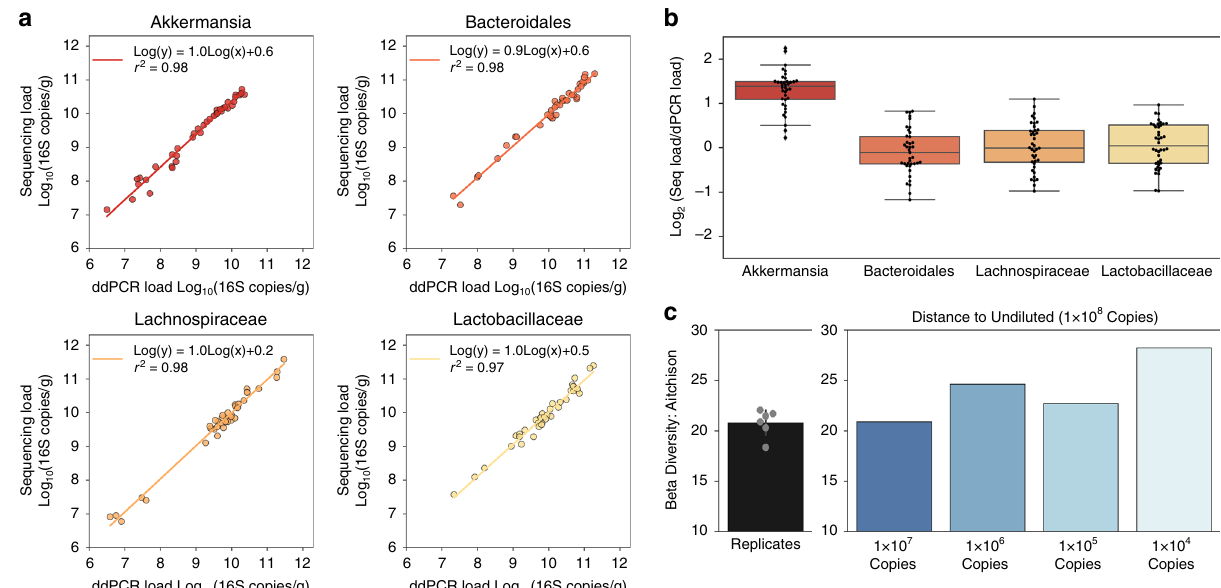
Fig. 3 Digital PCR (dPCR) anchoring of 16S rRNA gene amplicon sequencing provides microbial absolute-abundance measurements. Taxon-speci fi c dPCR demonstrates low biases in abundance measurements calculated by 16S rRNA gene sequencing with dPCR anchoring. a Correlation between the Log 10 abundance of four bacterial taxa as determined by taxon-speci fi c dPCR and 16S rRNA gene sequencing with dPCR anchoring (relative abundance of a speci fi c taxon measured by sequencing × total 16S rRNA gene copies measured by dPCR). b The Log 2 ratio of the absolute abundance of four bacterial taxa as determined either by taxon-speci fi c dPCR or by 16S rRNA gene sequencing with dPCR anchoring ( N = 32 samples). Data points are overlaid on the box and whisker plot. The body of the box plot goes from the fi rst to third quartiles of the distribution and the center line is at the median. The whiskers extend from the quartiles to the minimum and maximum data points within the 1.5× interquartile range, with outliers beyond. All dPCR measurements are single replicates. c Analysis of beta diversity in cecum samples at a series of 10× dilutions ( n = 1 for each dilution). Mean Aitchison distance for six pairwise comparisons of n = 4 sequencing replicates of the undiluted (10 8 copies) sample (black) is shown for reference (error bar is standard deviation). Individual data points are overlaid on the replicates bar